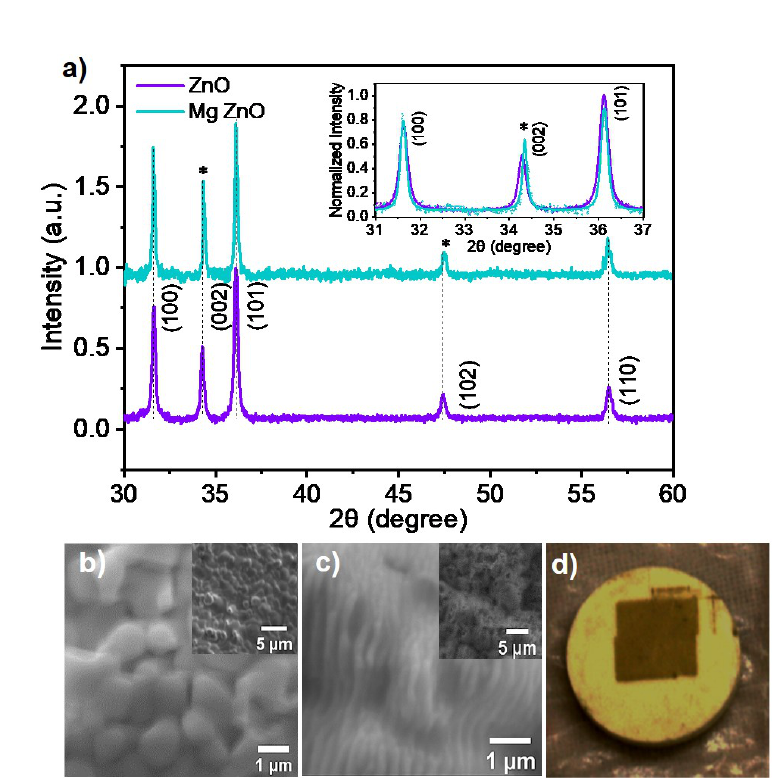
Figure 1. ( a ) The X-ray diffraction data of ZnO (violet) and Mg-doped ZnO (cyan) nanoparticles are compared here. The inset illustrates the peak shift between the two samples corresponding to the (002) plane. This evidences the presence of Mg 2 + ions in the ZnO lattice replacing a fraction of the Zn 2 + ions. Panels ( b , c ) are SEM images of regions of the pellet unexposed and exposed to the ablating fs pulses, respectively, shown in two different scales. This reveals quasi-periodic structures in the ablated region which are absent in the unexposed region ( b ), when both are imaged with the same magnification. ( d ) An image of the ZnO pellet used as the target in the fs-PLAL process. The light colored disk is the pellet prepared as described in the text. The dark patch inside this is the region where the target was ablated by fs laser pulses.